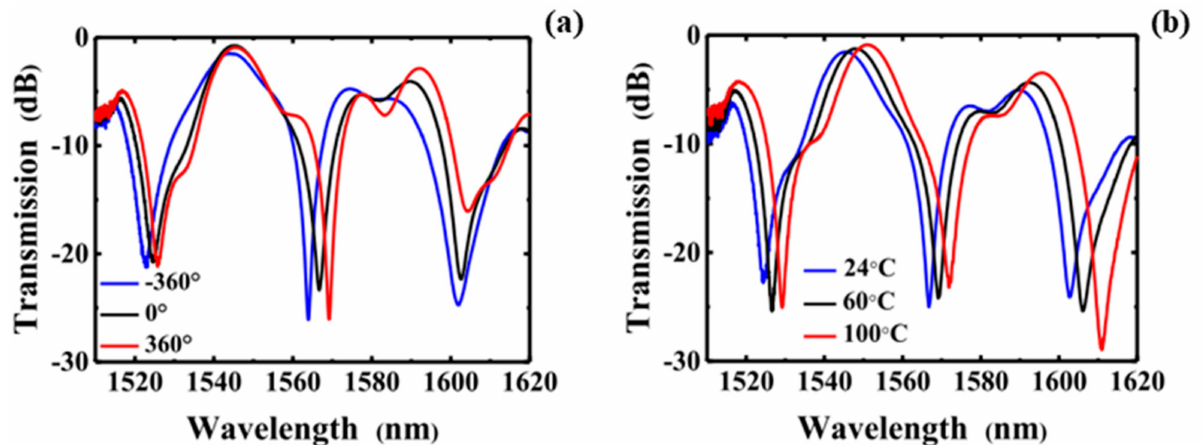
Figure 38. Transmission spectra of the 3-channel HLPG-based fiber sensor under different ( a ) torsion angles and ( b ) temperatures. Adapted with permission from ref.